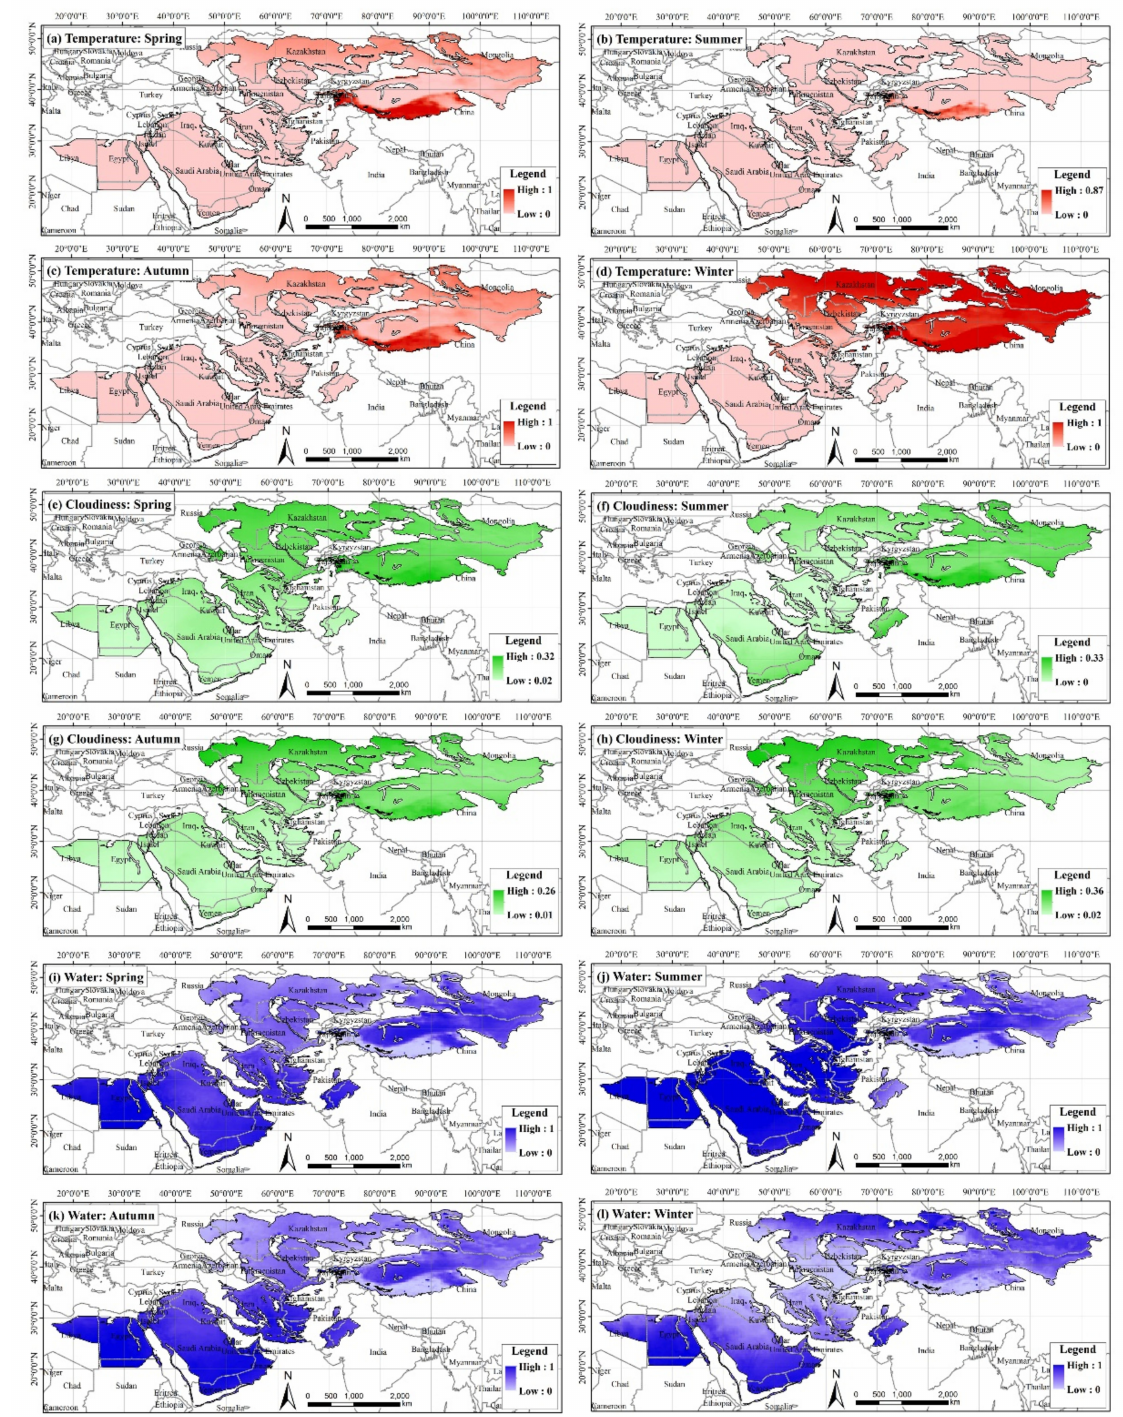
Figure 9. Distribution of single climatic constraint on vegetation dynamics in different seasons over the Silk Road Economic Belt between 1982 and 2015. ( a – l ) indicate the single constraint of temperature, cloudiness, and water on vegetation dynamics in spring, summer, autumn, and winter,